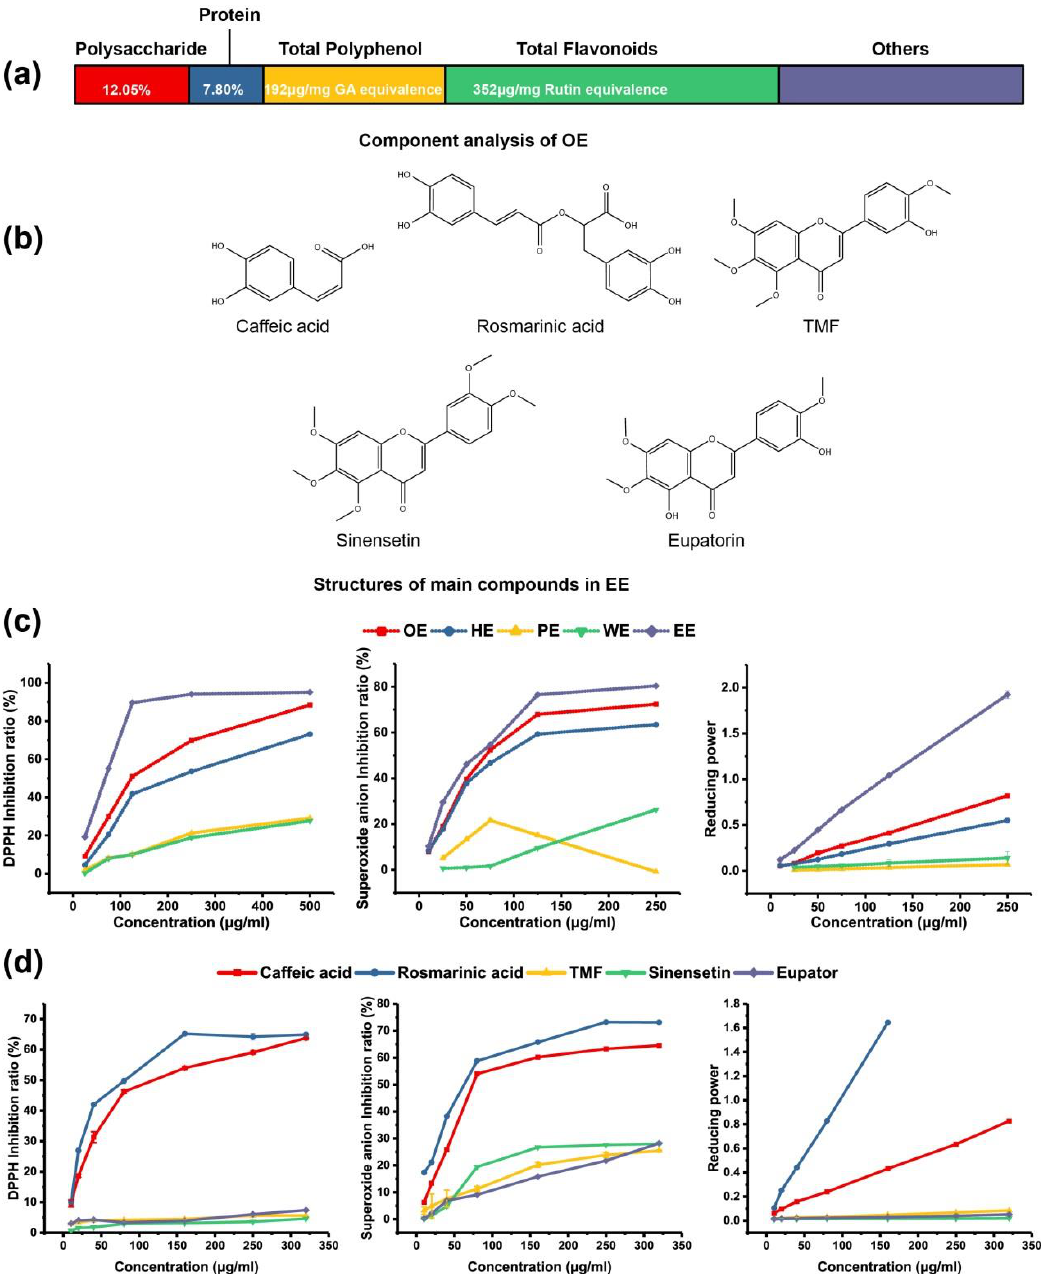
Figure 1. Content and antioxidant activity of the di ff erent components in Orthosiphon stamineus extract (OE). ( a ) Component analysis of OE. ( b ) Structures of the main compounds in ethyl acetate extract (EE). ( c ) Antioxidant activity of OE, water phase with high molecular weight (HE), water phase with small molecule content (LE), petroleum ether extract (PE), water extract (WE), and EE. ( d ) Antioxidant activity of the main compounds in EE. TMF = 3’-hydroxy-5,6,7,4’-tetramethoxyflavone (TMF).